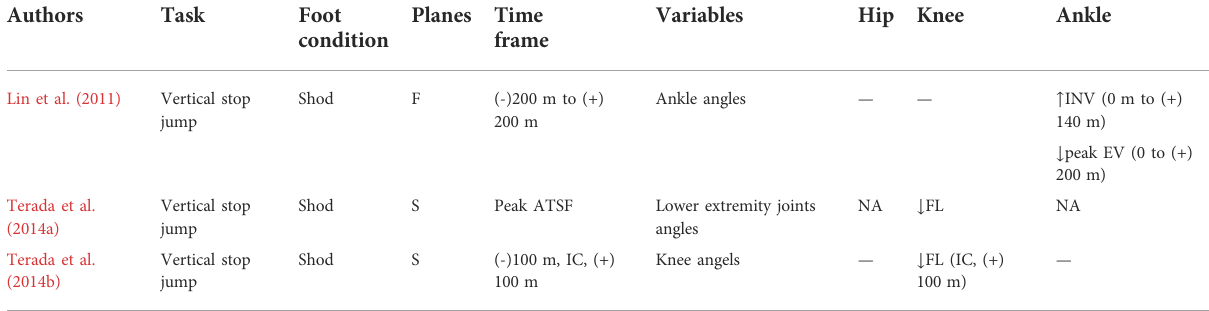
TABLE 3 Summary of articles related to stop